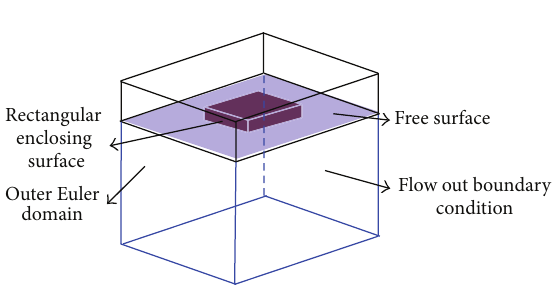
Figure 4: The outer Euler domain.